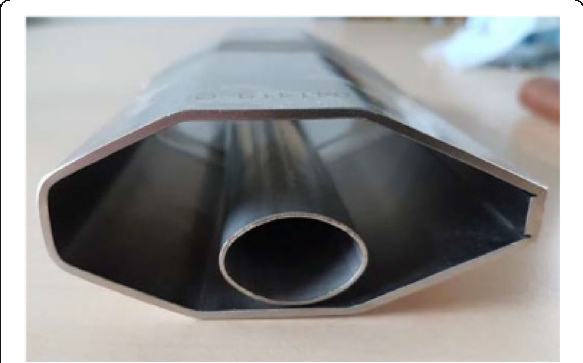
Fig. 8 Vacuum chamber comparison between 3GSR and 4GSR in